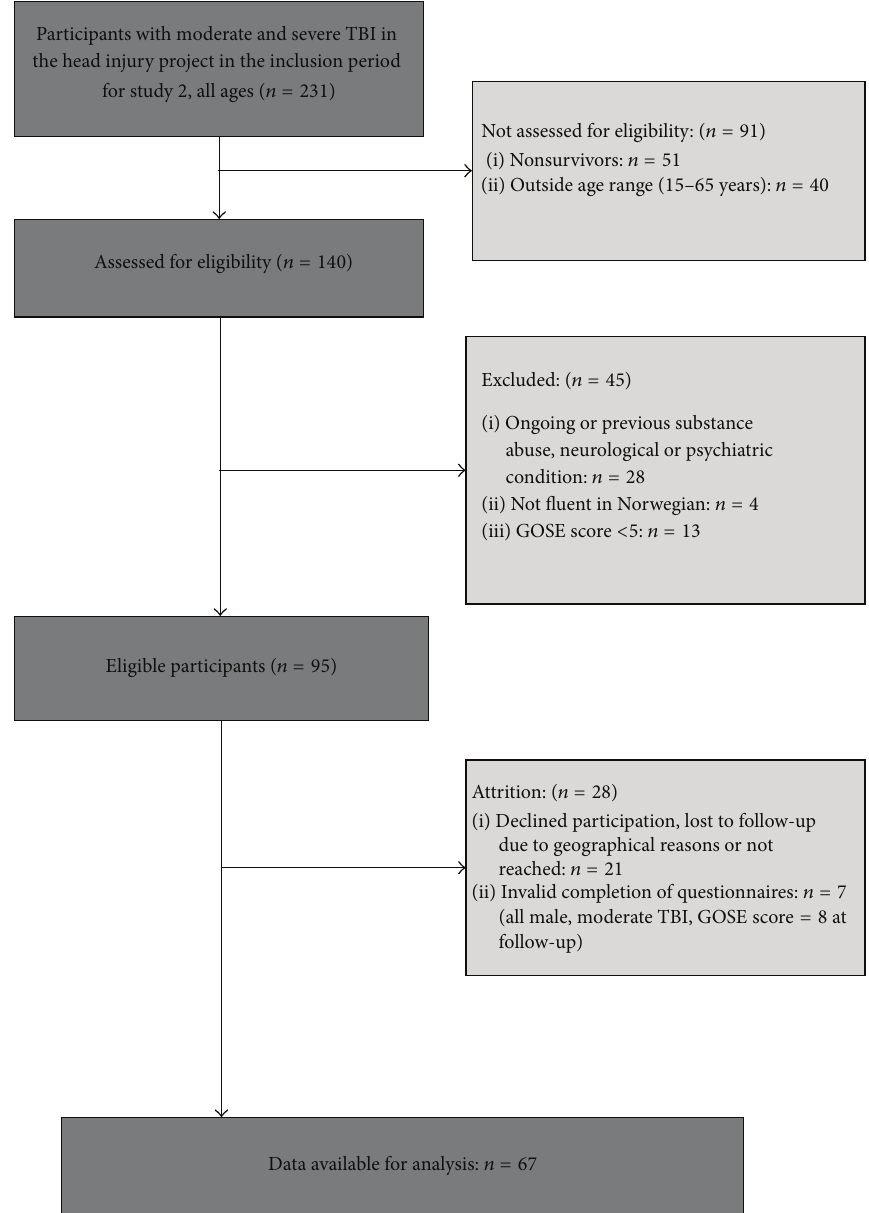
Figure 1: Flowchart illustrating sample selection and description of